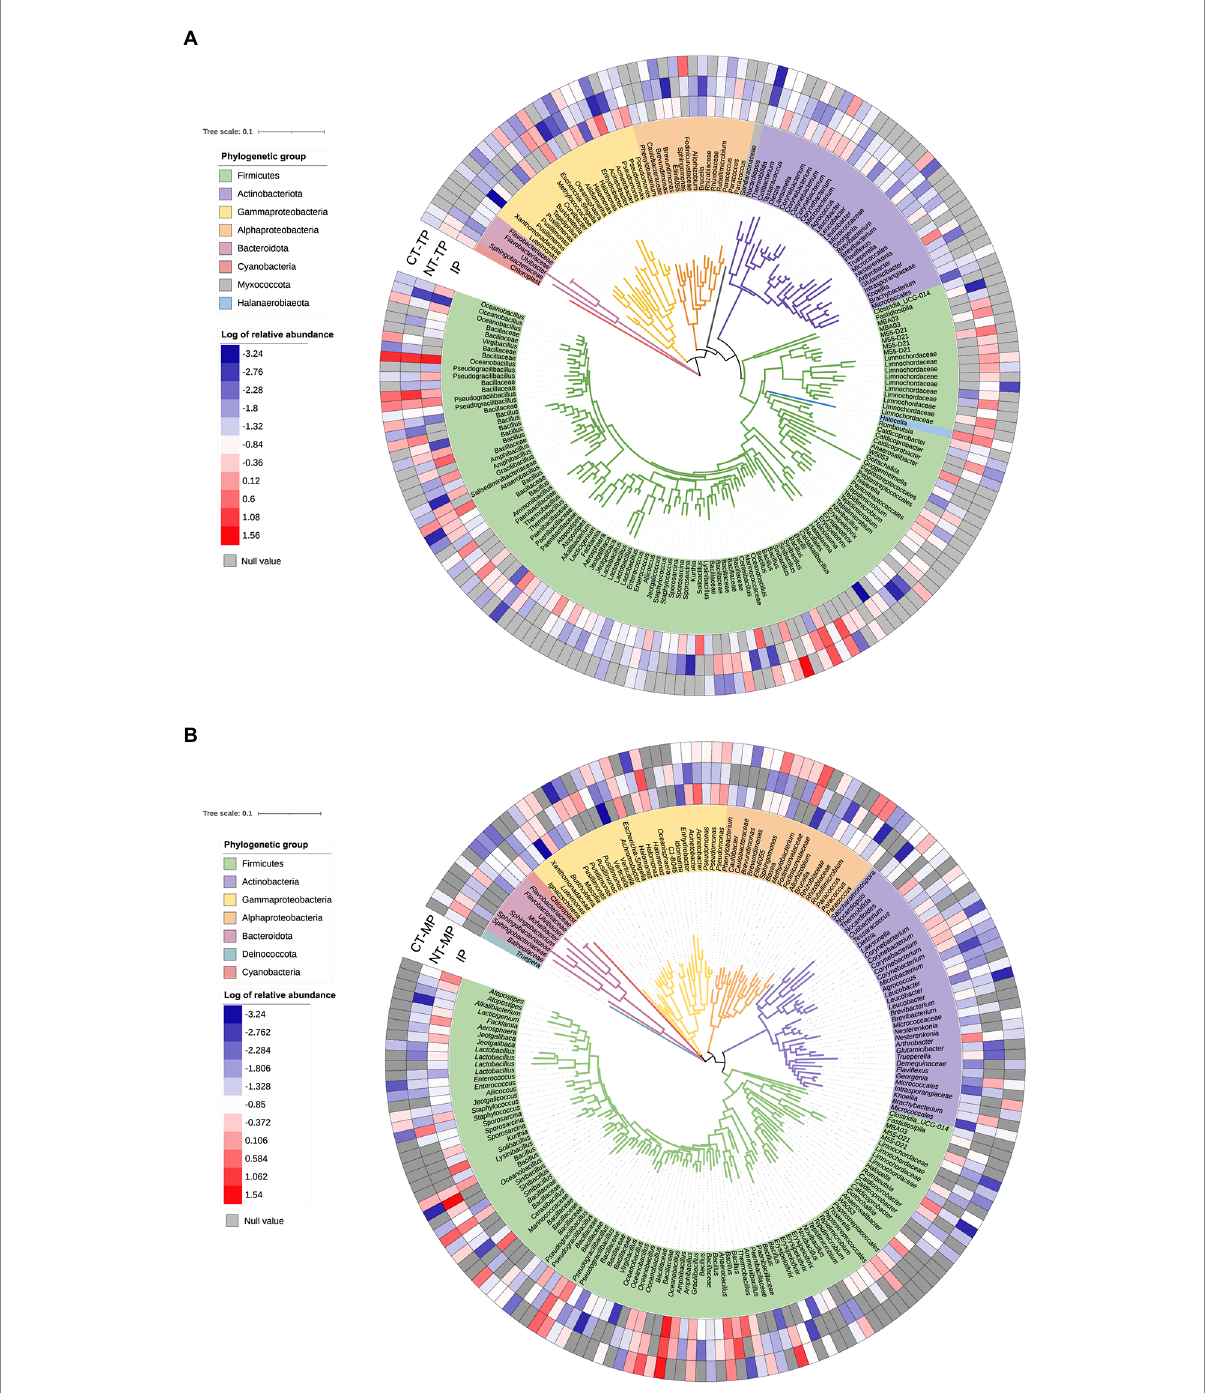
FIGURE 7 Phylogenetic tree showing the identified transconjugant OTUs that contributed more than 0.01% in normal thermophilic (NT) and continuous thermophilic composting (CT). (A) Showing transconjugants in the thermophilic phase. (B) Showing transconjugants in the mature phase. Colors of the branches mark different phylogenetic groups. Heatmap circles at the periphery of the tree represent the log of relative abundance of the OTU in the transconjugant pools. IP, TP, and MP represent the initial, thermophilic, and mature phases, respectively.